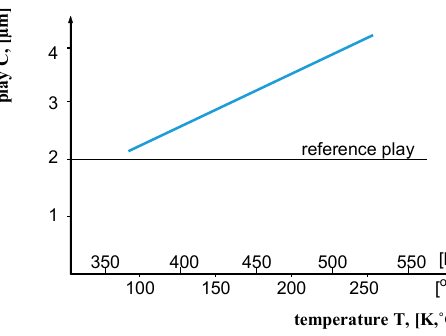
Figure 5. The play in the needle-nozzle holder precision pair of injector 4 as a function of operating temperature.